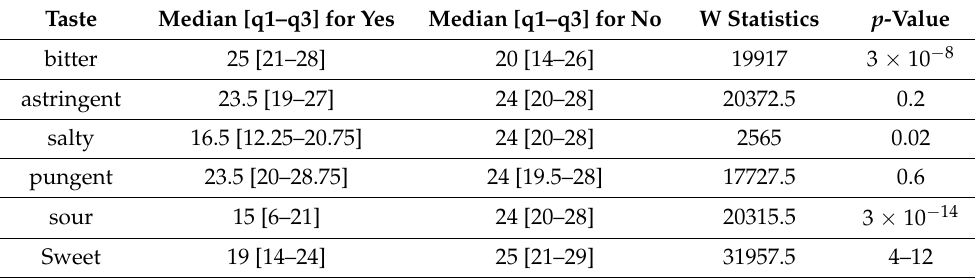
Table 3. Correlation between the count of inflammation-related targets and the taste as revealed by Mann–Whitney test. Q1, q3 = first and third quartiles. median [q1–q3] for yes/no = median [q1–q3] for the compounds with/without the corresponding